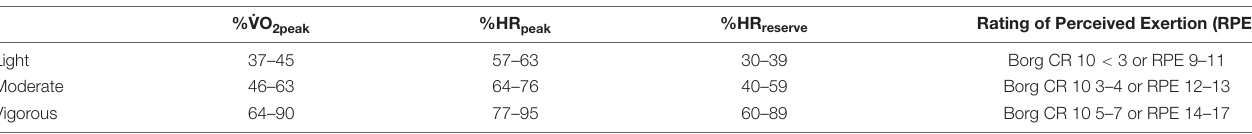
TABLE 3 | Classification of exercise